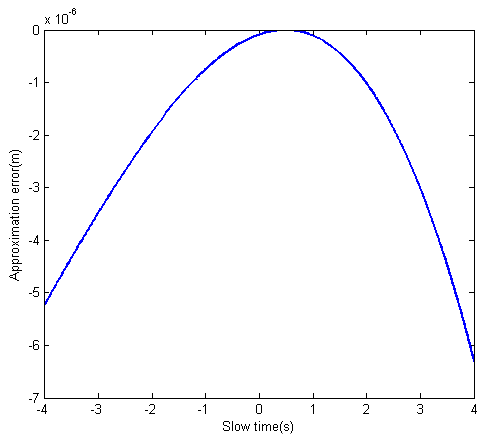
Figure 3. Slant range approximation error.